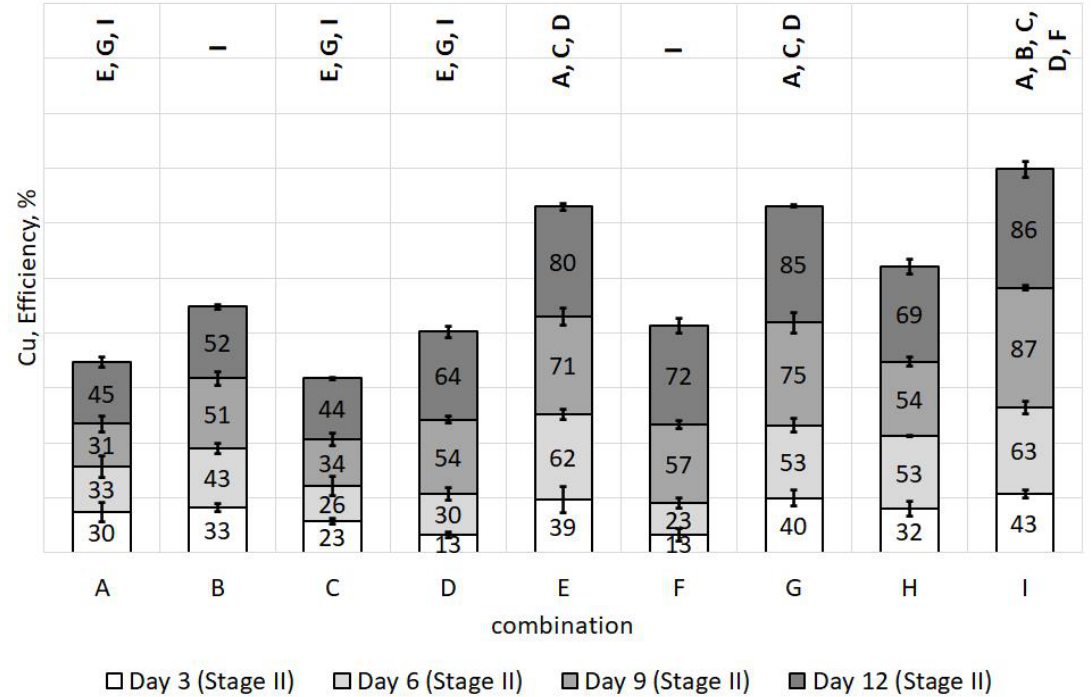
Figure 12. Effectiveness of Cu release to the dissolved fraction of leachate (Stage II).